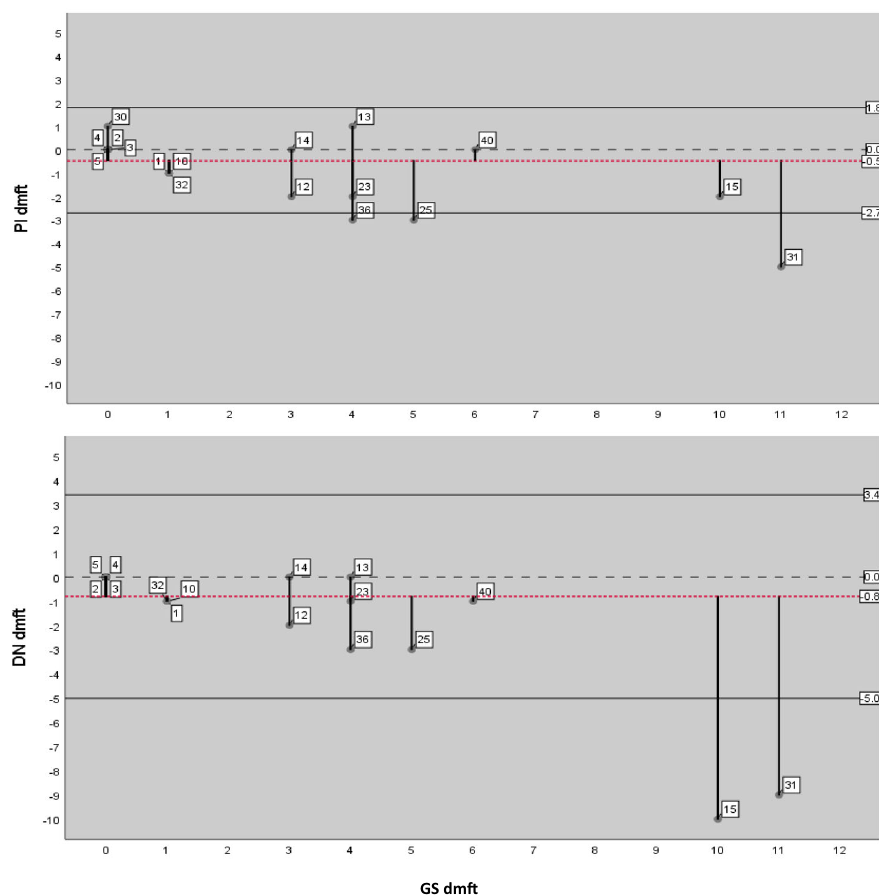
Fig. 1 Bland-Altman plots showing the image assessors with the most (PI) and least (DN) agreement with the GS for dmft. Plots show 95% con fi dence intervals, means and divergent cases, in particular, case 15 and